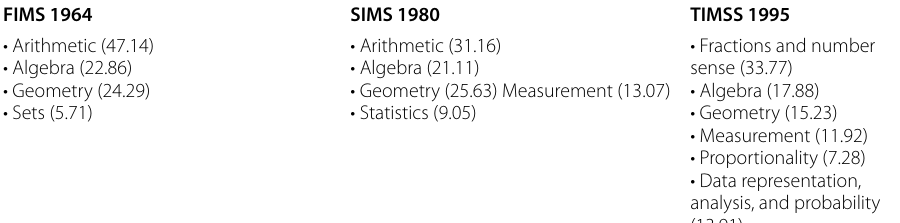
Table 7 Content areas of the mathematics achievement tests